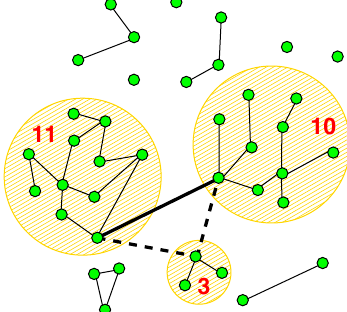
FIG. 1. Sketch of the model. Select three vertices and connect those two vertices that reside in clusters whose size difference is minimal. Here, a link between a cluster of size 10 and size 11 is established because the other two differences, 10 (cid:1) 3 ¼ 7 and 11 (cid:1) 3 ¼ 8 , are both larger than 11 (cid:1) 10 ¼ 1 . The model does not suppress the growth of the largest cluster by definition— contrary to many other explosive percolation processes. In con- trast to what the sketch might suggest, no spatial embedding and hence no metric is involved